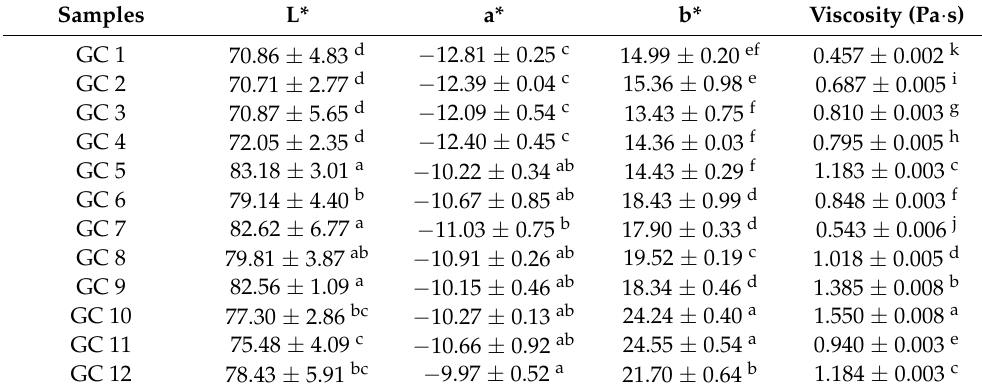
Table 4. The color characteristics and viscosity of different